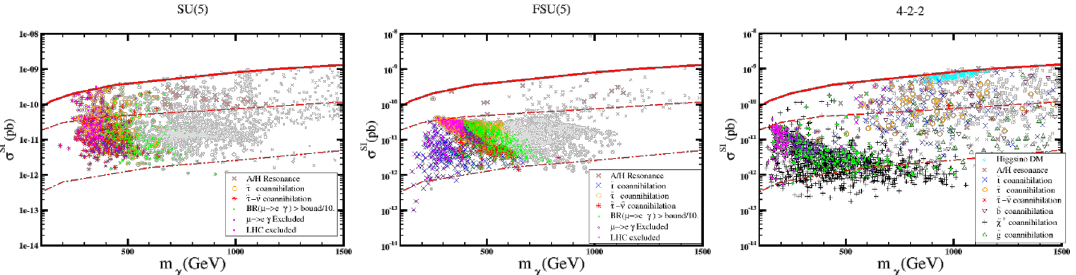
Figure 8 . SI neutralino-nucleon cross section versus m (cid:31) in SU(5), FSU(5) and the 4-2-2 escenarios. The solid lines corresponds to the Xenon-1T bound [11], and the dashed and dot-dashed lines correspond to the projected sensitivities of the LZ [125] and DARWIN [126]